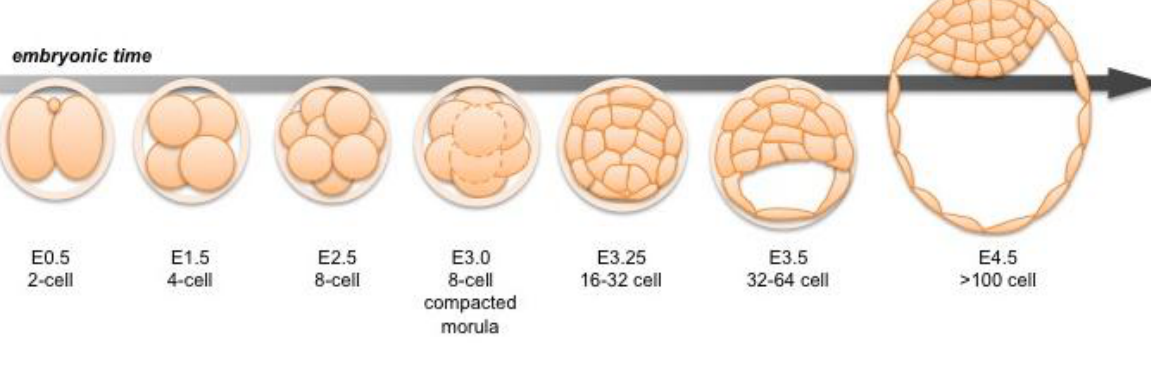
Figure 2. The TE vs. ICM cell fate decision in the mouse embryo. This cell fate